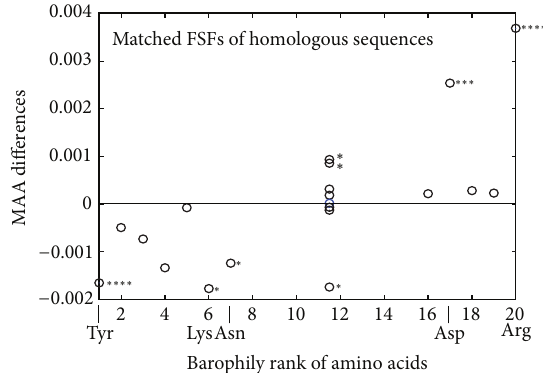
Figure 6: MAA analysis of matching FSF domains within pairs of homologous sequences confirms significant preferences of the barophilic organism for Arg and Asp and a preference of the nonbarophilic organism for Tyr, Lys, and Asn. Other barophilic and nonbarophilic amino acids do not display a significant difference in use. Statistical significance is marked with stars as described in Figure 2. A total of 241 matching FSFs were